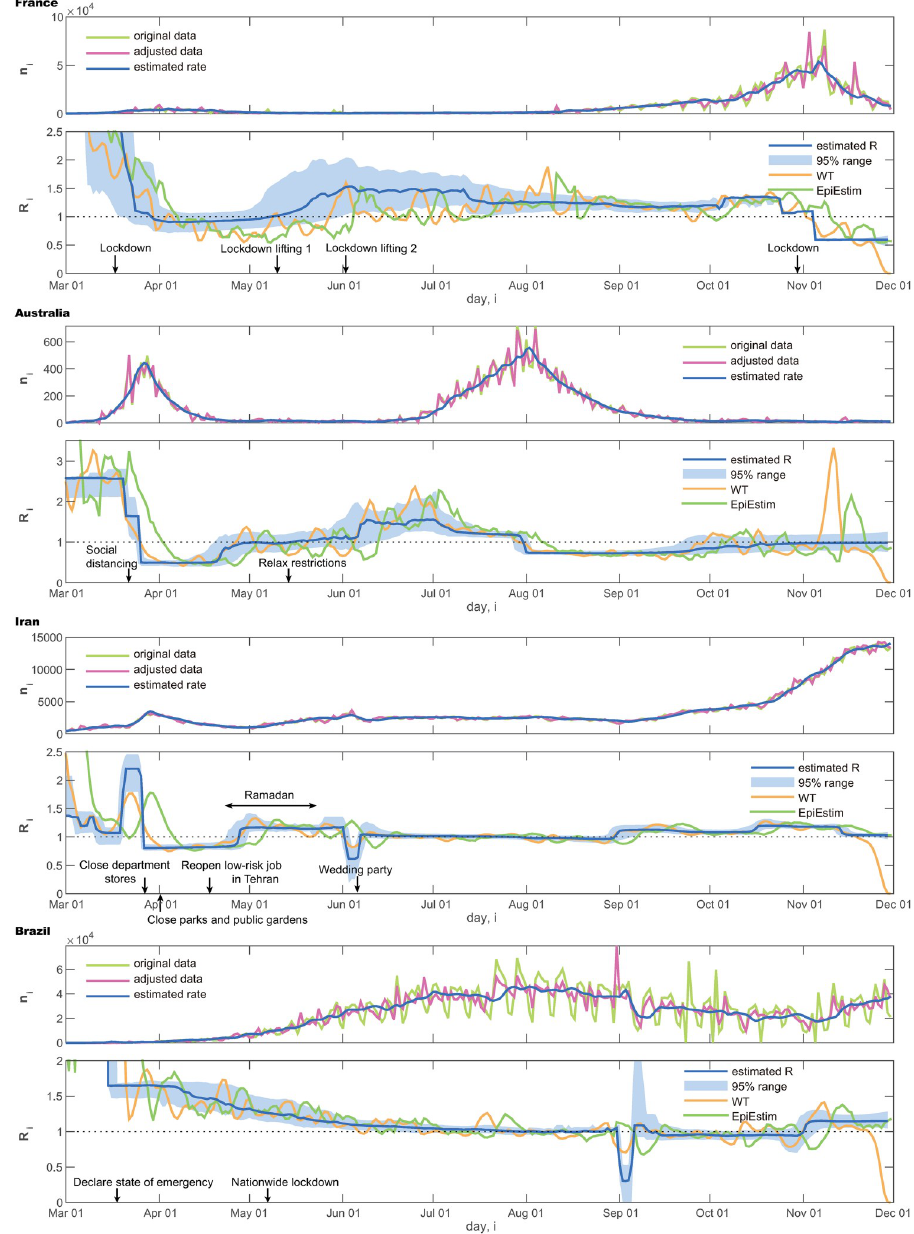
Fig 6. Number of daily new cases and the reproduction number ^ R estimated using thestate-space method. France, i Australia, Iran, and Brazil. The minimum reproduction number achieved in each country. The degree of a drop in the estimated reproduction number could reflect the impact of non-pharmaceutical interven- tions such as a lockdown. It might be possible to quantify the effectiveness of political interven- tions in each country in terms of the relative percentage reduction in the reproduction number [13]. Here we searched for the minimum reproduction number averaged over 10 days that was achieved in each country. Fig 8A depicts the reproduction number for 10 days whose